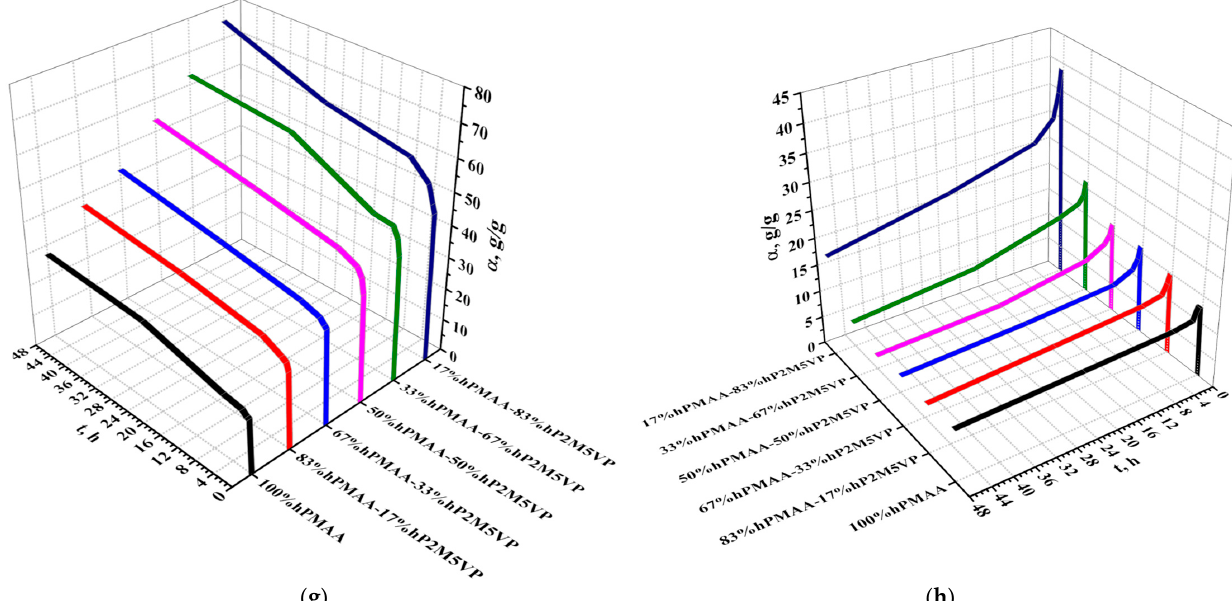
Figure 3. Swelling degree of acidic hydrogels in aqueous medium ( a , c , e , g ) and lanthanum nitrate ( b , d , f , h ).